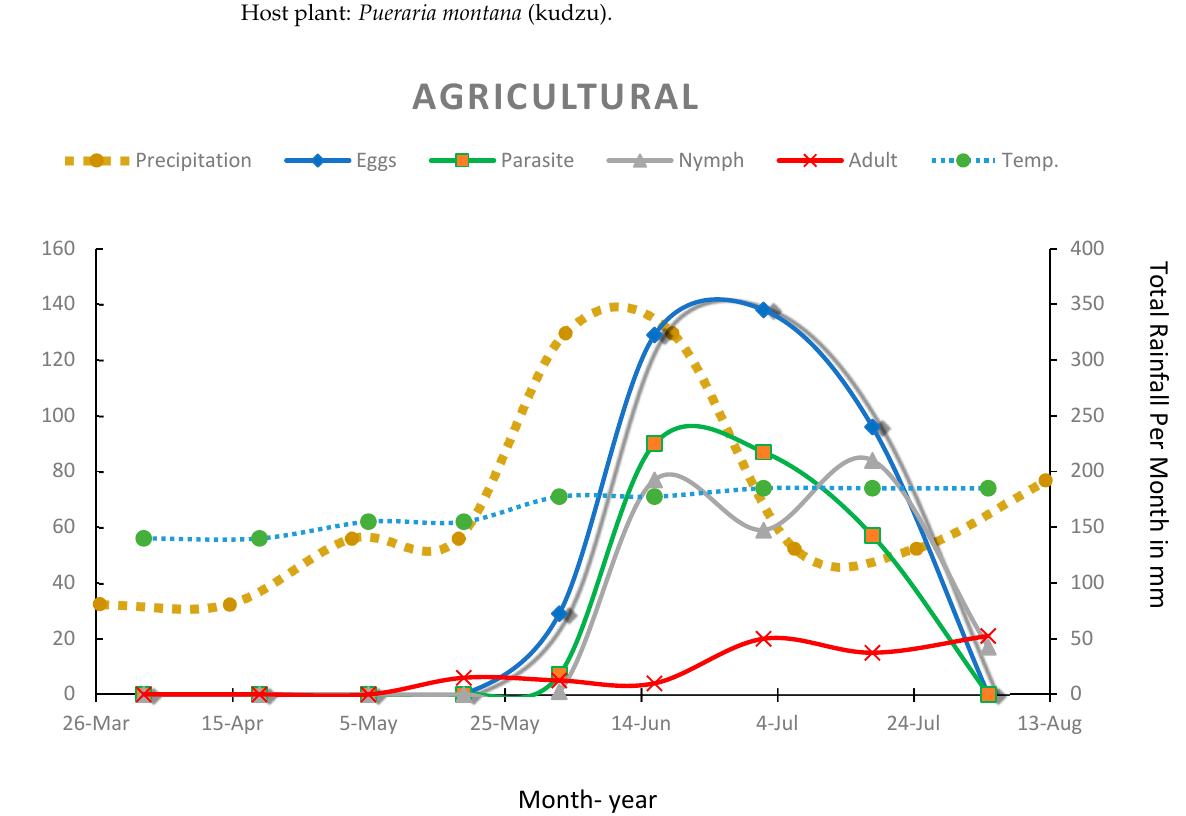
Figure 7. Population dynamics of M. cribraria and P. saccharalis for most active agricultural site 2017. Host plant: soybean.